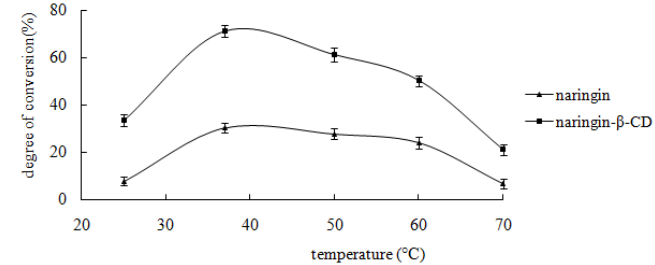
Figure 4. Effect of reaction temperature. Ten milligrams of substrate, 10 mg snailase, and 10 mL glacial acetic acid and anhydrous sodium acetate buffer (pH 4.5) were mixed in a 1 mL Eppendorf tube. Subsequently, the buffer was incubated in a HH-4 digital constant temperature water bath at 25, 37, 50, and 60 °C for 24 h. Each point represented the mean ± SD ( n =